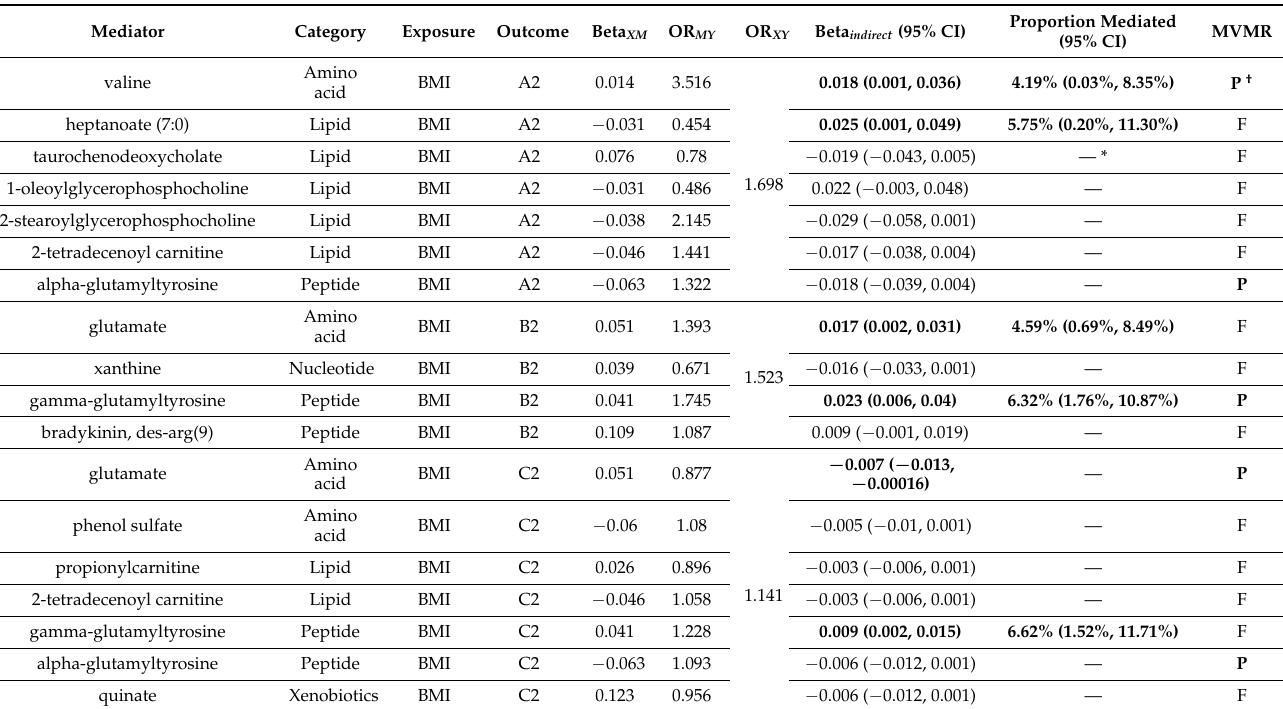
Table 3. Mediation effects of human serum metabolites in the total effect between obesity and COVID-19